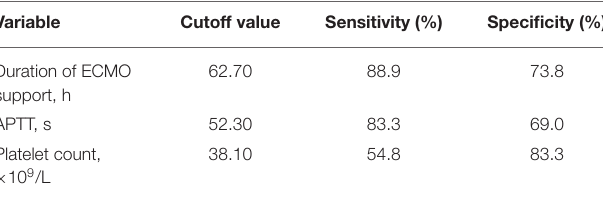
TABLE 6 | Cutoff value, sensitivity and specificity of ROC curve.